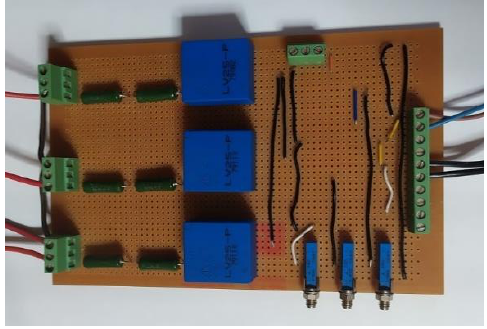
Figure 14. External module with three LEM LV-25s.